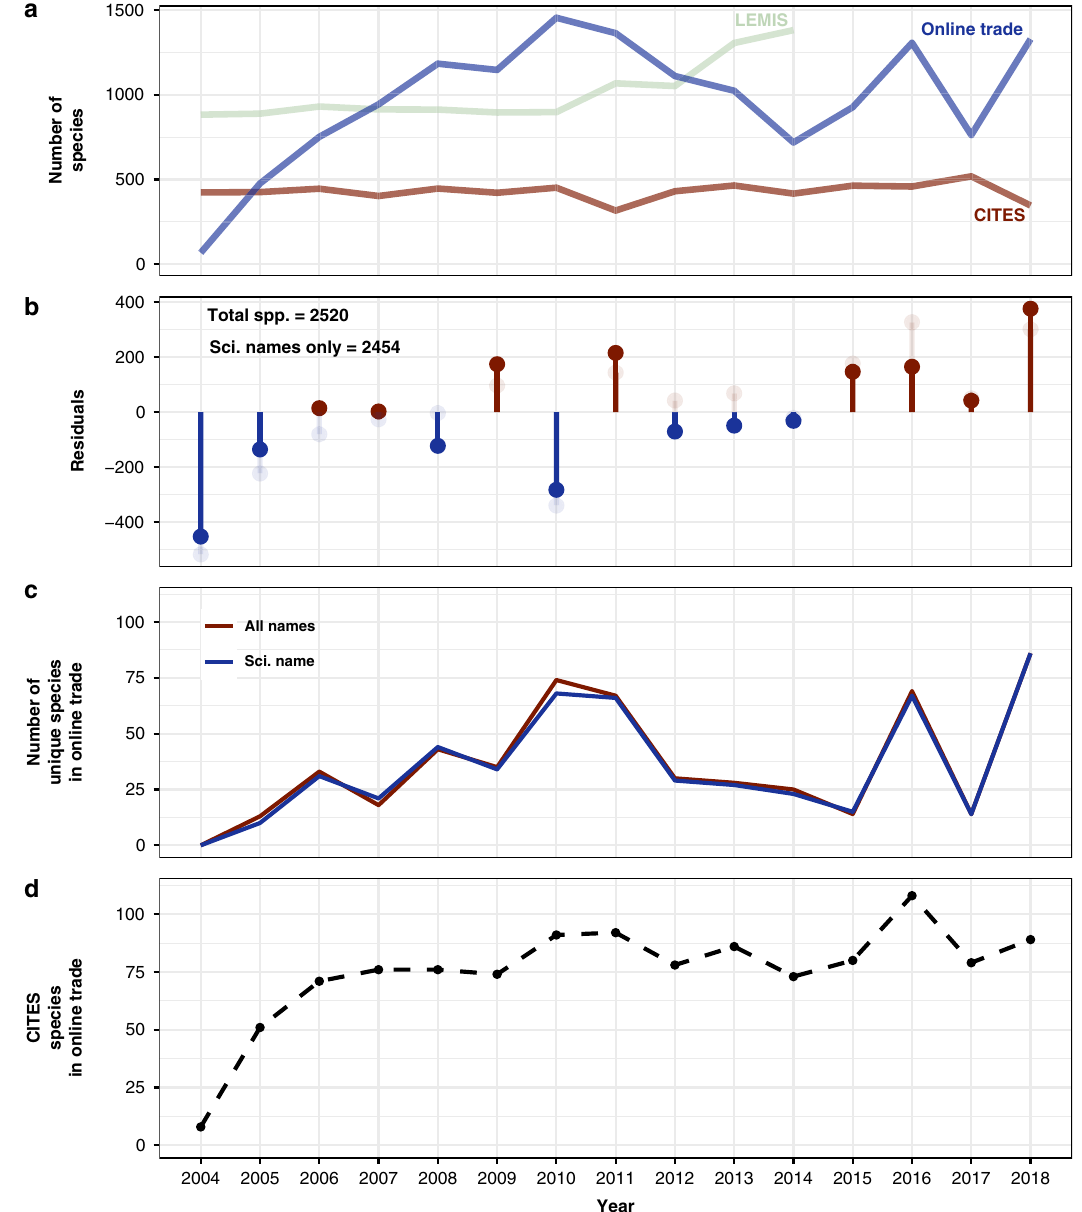
Fig. 2 Number and uniqueness of species detected during 2004 – 2018. a The raw species counts from CITES trade database, LEMIS and detected on the top reptile selling website (all keywords). b Trend in number of species detected on the most species-rich reptile trading website. Solid lollipops show residuals from a linear relationship between the number of pages available in a year and the number of species detected using all keywords. Light coloured lollipops show the residual species counts each year detected by only scienti fi c names. c The number of species detected on the most species-rich reptile trading website unique to each year in the online trade. The red line shows the unique species detected using all keywords, while the blue line shows the species detected by scienti fi c name only. d The number of species detected on the most species-rich reptile trading website listed in any CITES appendix in that year. Whether a species was included in a CITES appendix was determined by exact matching of Reptile Database name with CITES listed